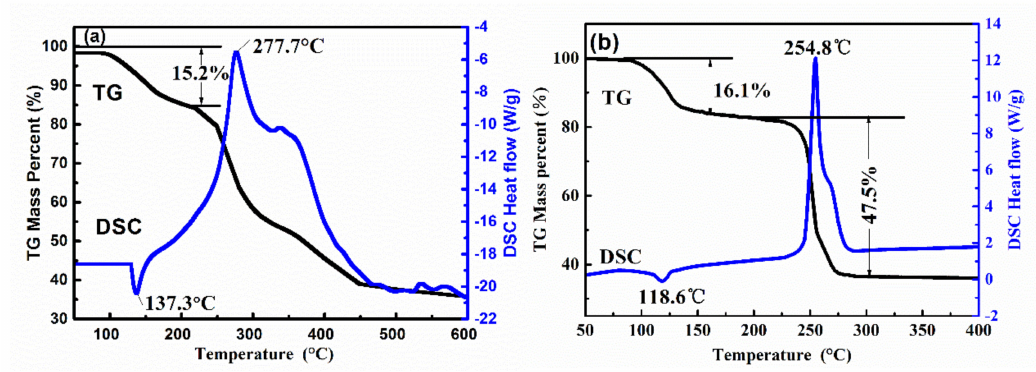
Figure 5. TG-DSC curves of complexes 1 ( a ) and 2 ( b